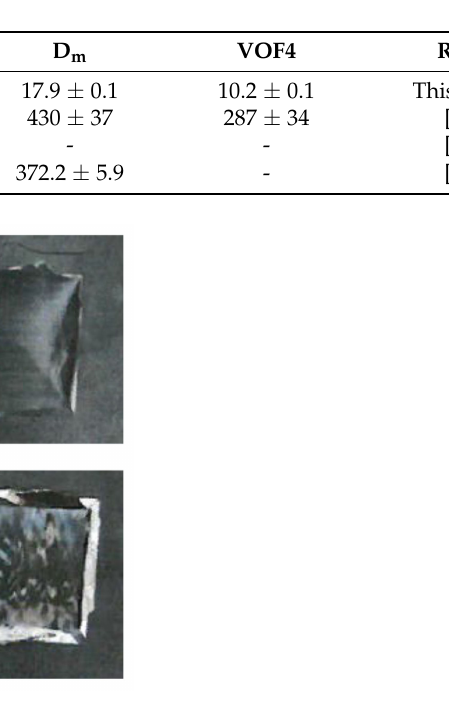
Figure 10. CF/PPS composites (processing temperatures of 280 ◦ C) ( a ) before and ( b ) after smoke density